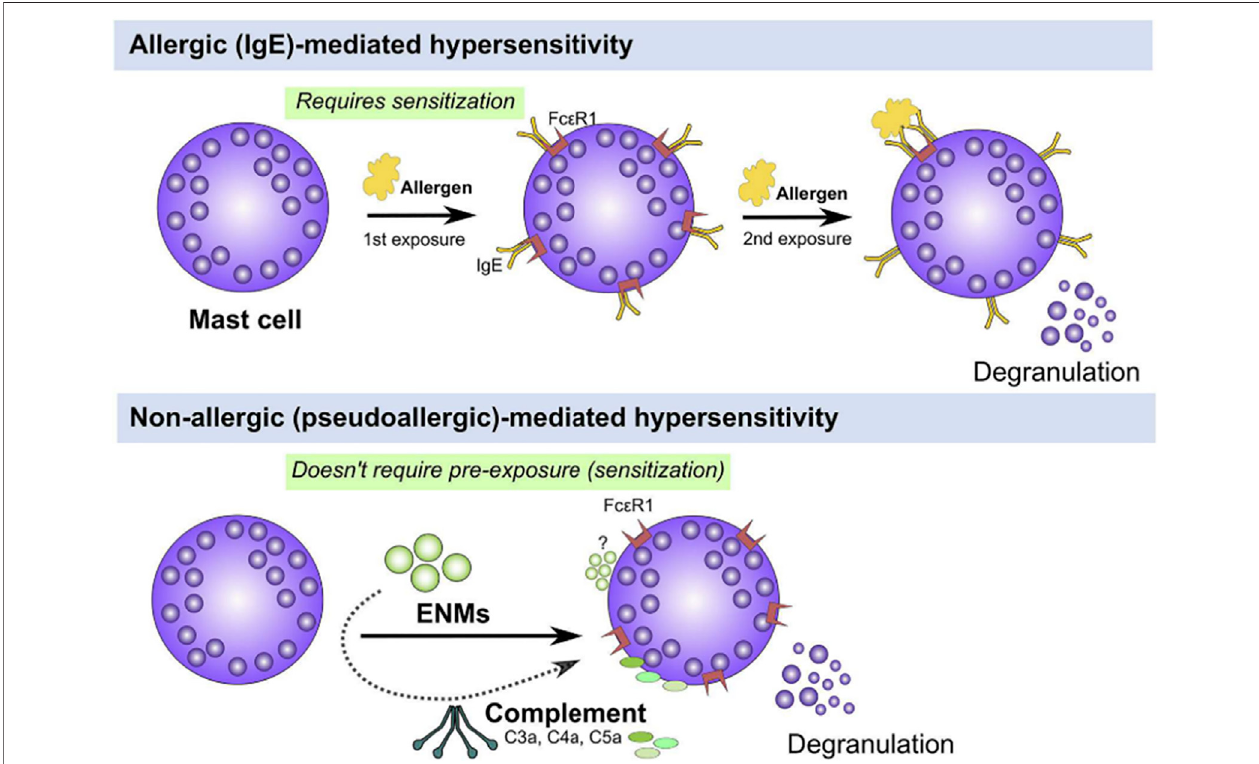
FIGURE 5 | Hypersensitivity reactions: IgE-mediated and non-IgE-mediated. Mast cells can be activated either through IgE or non-IgE pathways. IgE stimulation (top panel) requires pre-exposure to an antigen ( e.g. , pollen, mite, etc.) and upon a second exposure, IgE-bound Fc ε R1 are crosslinked leading to activation of signal transduction pathways that culminate in cell degranulation and activation (top panel). Mast cells can be also activated through non-IgE pathways (bottom panel) by a wide range of materials ( e.g. , cytokines, complement fragments, basic polypeptides, environmental toxicants, toxic venoms, etc) which do not require prior exposure and may lead to mast cell degranulation and/or activation (bottom panel). Figure and captions are taken from ref (Alsaleh and Brown,